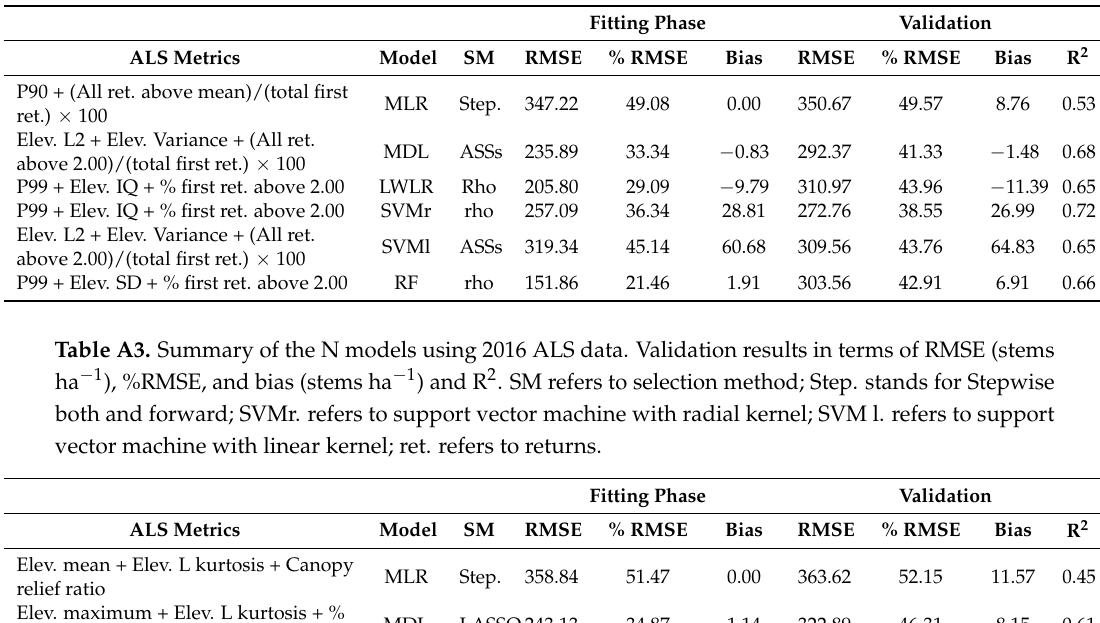
Table A2. Summary of the N models using 2011 ALS data. Validation results in terms of RMSE (stems ha − 1 ), %RMSE, and bias (stems ha − 1 ) and R 2 . SM refers to selection method; Step. stands for Stepwise both and forward; SVMr. refers to support vector machine with radial kernel; SVM l. refers to support vector machine with linear kernel; ret. refers to returns.